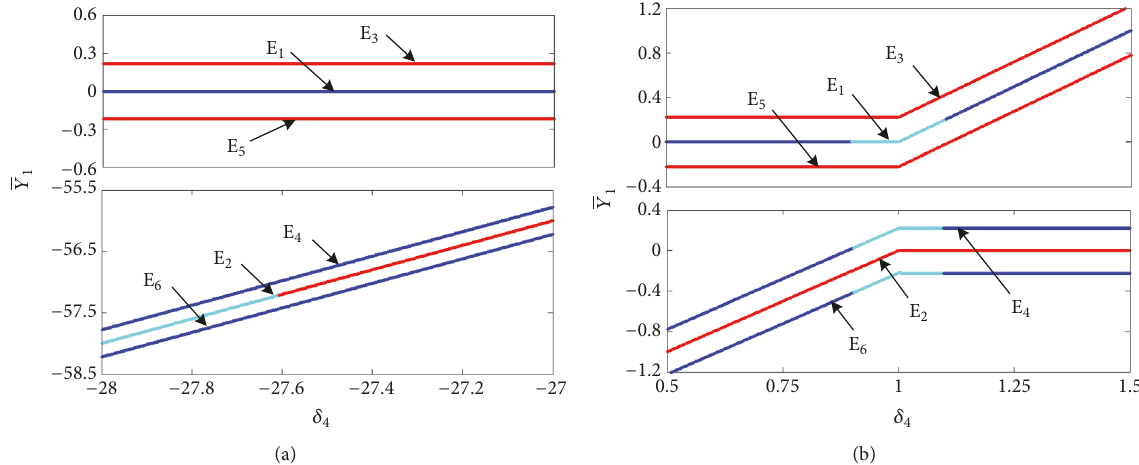
Figure 10: Locations and stabilities of the six determined equilibrium points, where the red lines indicate index-2 saddle-foci, the blue lines represent index-1 saddle-foci, and the cyan lines indicate saddle points. (a) Locations and stabilities of six equilibrium points for − 28 < 𝛿 < − 27. (b) Locations and stabilities of equilibrium points for 0.5 < 𝛿 4